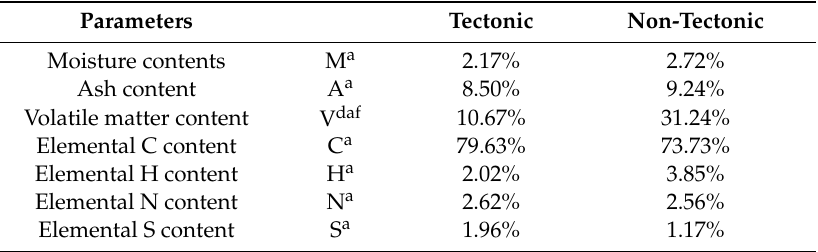
Table 1. Proximate analyses and elemental analyses of coal samples.